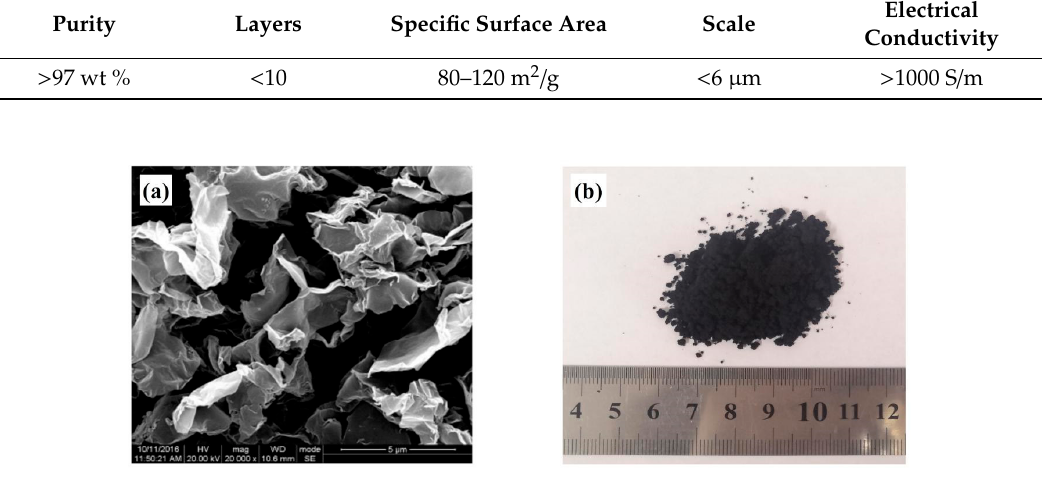
Figure 1. ( a ) SEM of Industrial Reduced Graphene Oxide (source: the official website of Chengdu organic chemicals Co. Ltd. Chinese Academy of Sciences). ( b ) A picture of graphene powder.